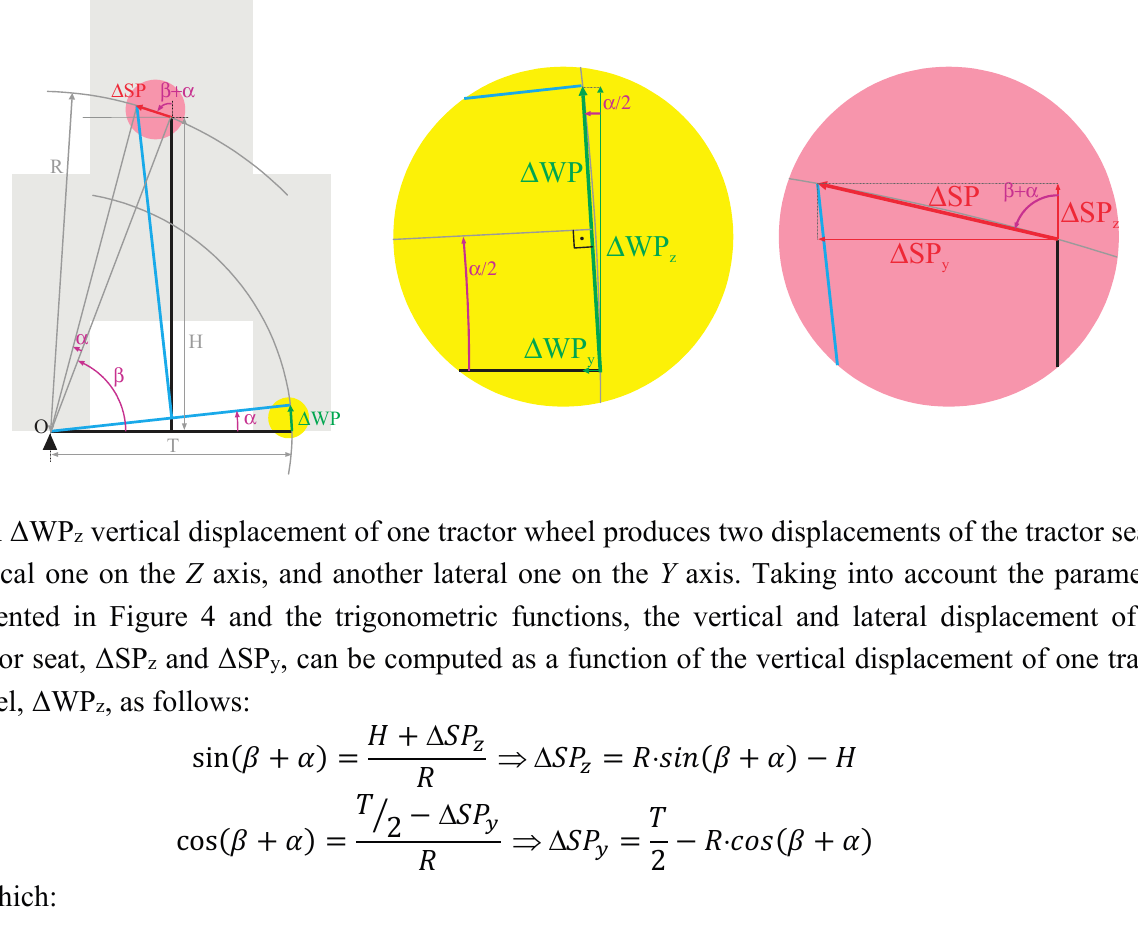
Figure 4. Geometrical relation between tractor seat movement Δ SP over the YZ plane and displacement of the rear tractor wheel Δ WP. Graphs represent the rear view of the